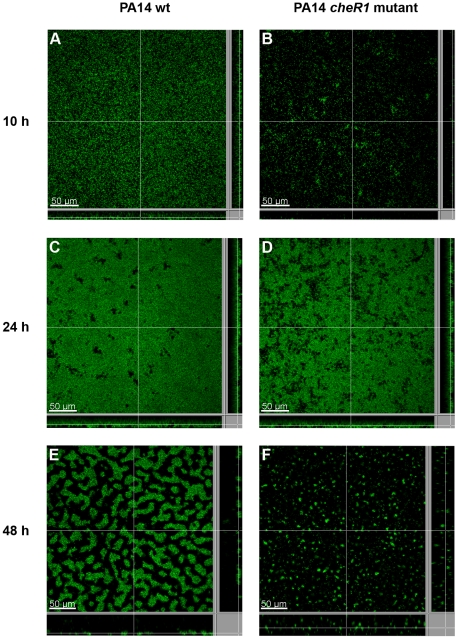
Confocal laser scanning micrographs of P. aeruginosa biofilms grown in LB.Biofilm development in a well of a 96-well plate at (A, B) 10 h, (C, D) 24 h and (E, F) 48 h is shown for (A, C, E) PA14 wild-type carrying the GFP-expression vector pSunny and (B, D, F) the PA14 cheR1 transposon mutant carrying the GFP-expression vector pSunny. The central image shows a XY section through the biofilm and the flanking pictures show vertical sections. Scale bars, 50 µm.